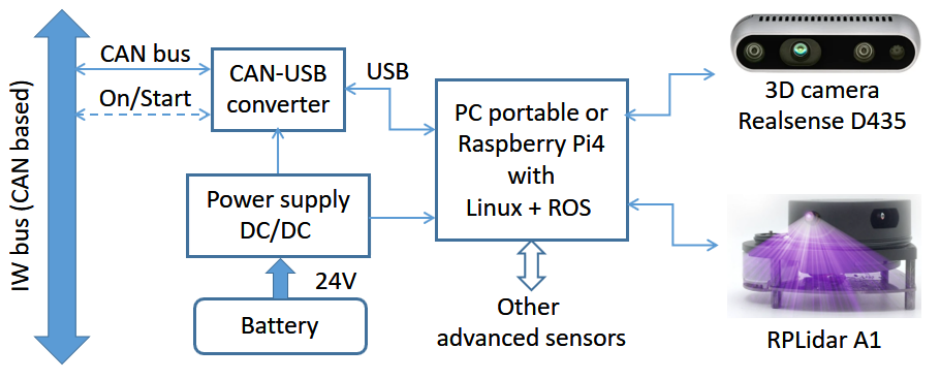
Figure 11. Block diagram of the sensor node, showing the ultrasonic ring and